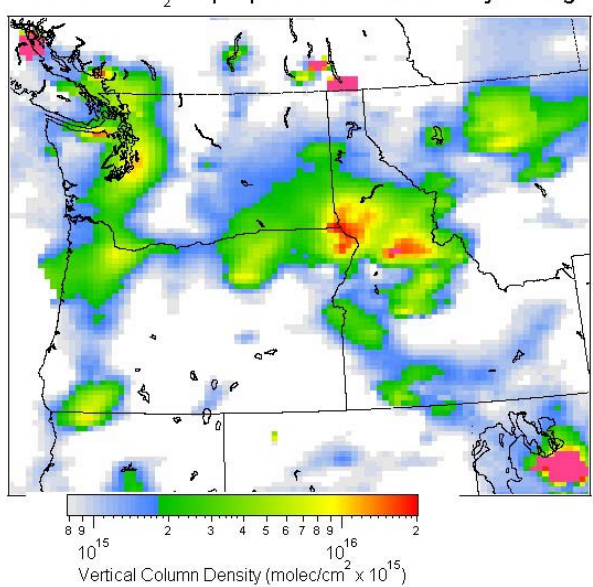
Fig. 15. AIRPACT tropospheric NO 2 column with the daily aver- aging kernels from OMI applied to AIRPACT are shown for a sum- mer (July 2007) monthly average: AIRPACT × NASA AK using the code provided by Bucsela using an integration method similar to the OMI data product. This integration technique is a function of pressure per layer but not temperature or layer thickness. Com- pared to the upper right panel of Fig. 14, this method decreases the background bias but also leads to erroneously large values at times (shown as pink).